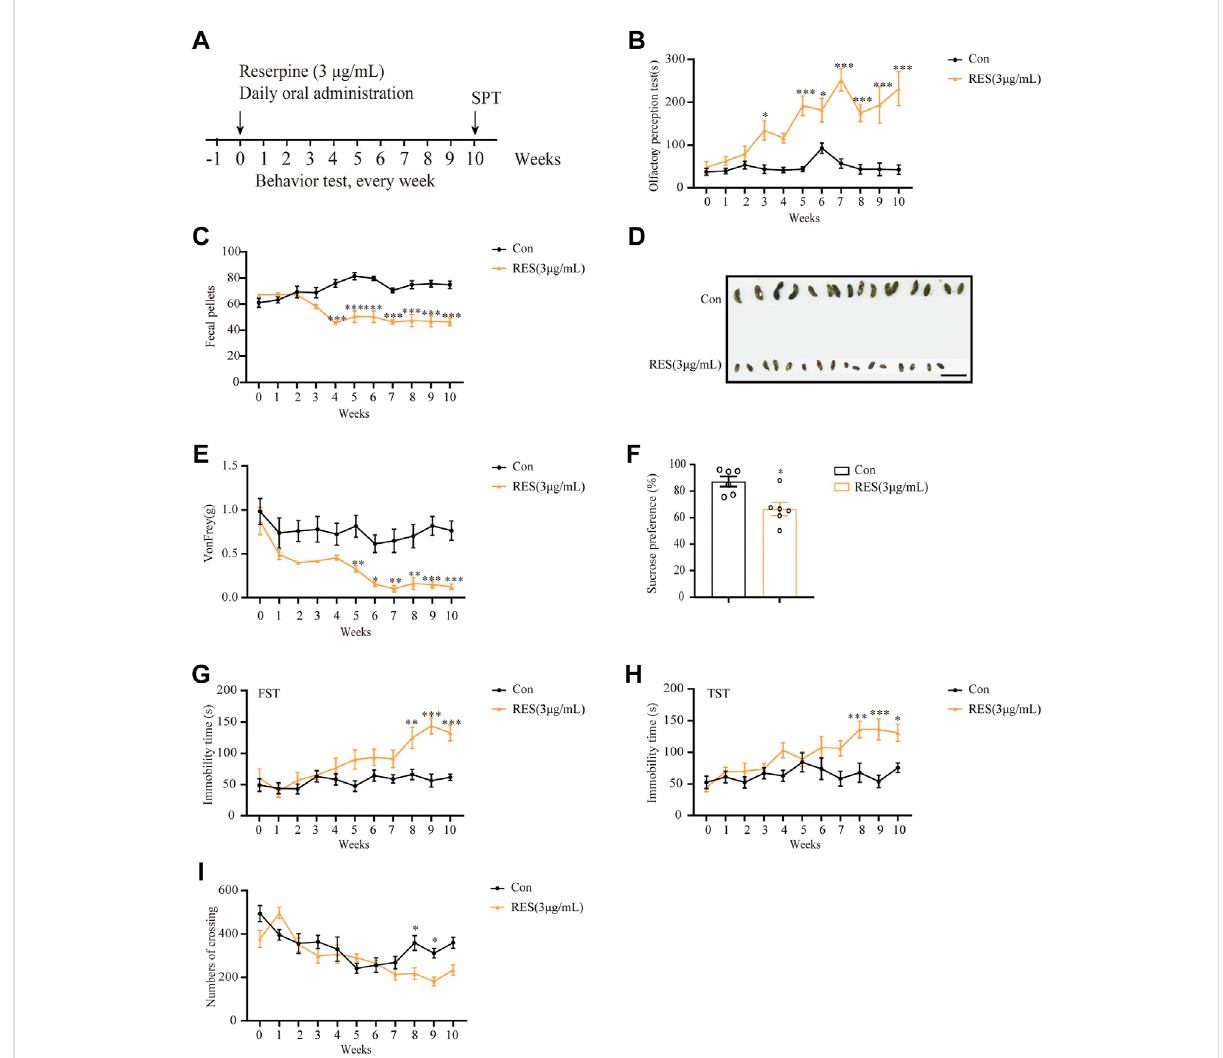
FIGURE 6 Reserpine induced PD-like non-motor symptoms in mice. (A) Flow chart of the experiment. (B) Reserpine (3 μ g/ml) increased the time for olfactory perception in mice ( n = 6 for each group, two-way ANOVA with Sidak post hoc test, * p < 0.05, ** p < 0.01, *** p < 0.001 vs. control). (C) Reserpine (3 μ g/ml)decreasedfecalpellets( n =10foreachgroup,two-wayANOVAwithSidak posthoctest,*** p < 0.001vs.control). (D) Reserpine (3 μ g/ml) induced changes in the shape of the stool; scale bar: 1 cm. (E) Reserpine (3 μ g/ml) decreases mechanical pain threshold by von Frey test ( n = 11 for each group, two-way ANOVA with Sidak post hoc test, * p < 0.05, ** p < 0.01, *** p < 0.001 vs. control). (F) The sucrose preference rate decreased in mice administered with reserpine (3 μ g/ml) ( n = 6 for each group, student t-test, * p < 0.05 vs. control). (G) The immobility time in the forced swimming test increased in mice administered with reserpine (3 μ g/ml) ( n = 10 for each group, two-way ANOVA with Sidak post hoc test, ** p < 0.01, *** p < 0.001 vs. control). (H) The immobility time in the tail suspension test increased in mice administered with reserpine (3 μ g/ml) ( n = 9 for each group, two-way ANOVA with Sidak post hoc test, * p < 0.05, *** p < 0.001 vs. control). (I) The number of crossing events in thecentral area decreased in mice administered with reserpine (3 μ g/ml) ( n = 9 for each group, two-way ANOVA with Sidak post hoc test, * p < 0.05 vs. control).